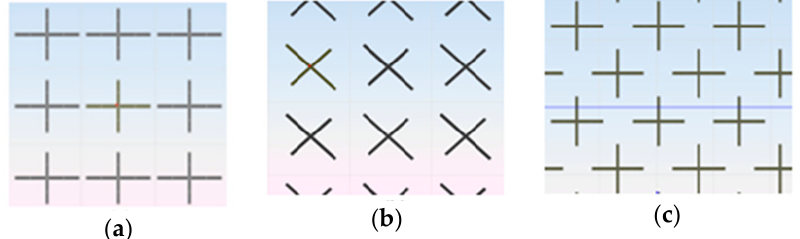
Figure 5. Aspect of the periodic lattice: ( a ) cross element on its original position with its arms parallel to the vertical and horizontal lines of the paper; ( b ) cross element rotated 45deg; ( c ) cross element rotated 45deg shown when the paper was also rotated 45deg.